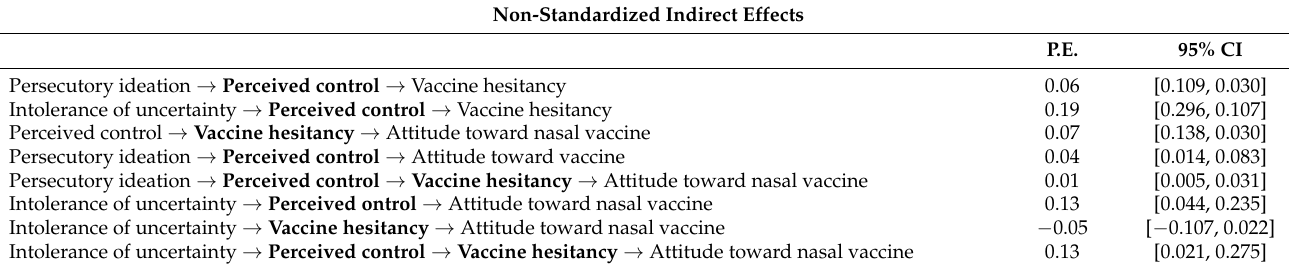
Table 4. Non-standardized indirect